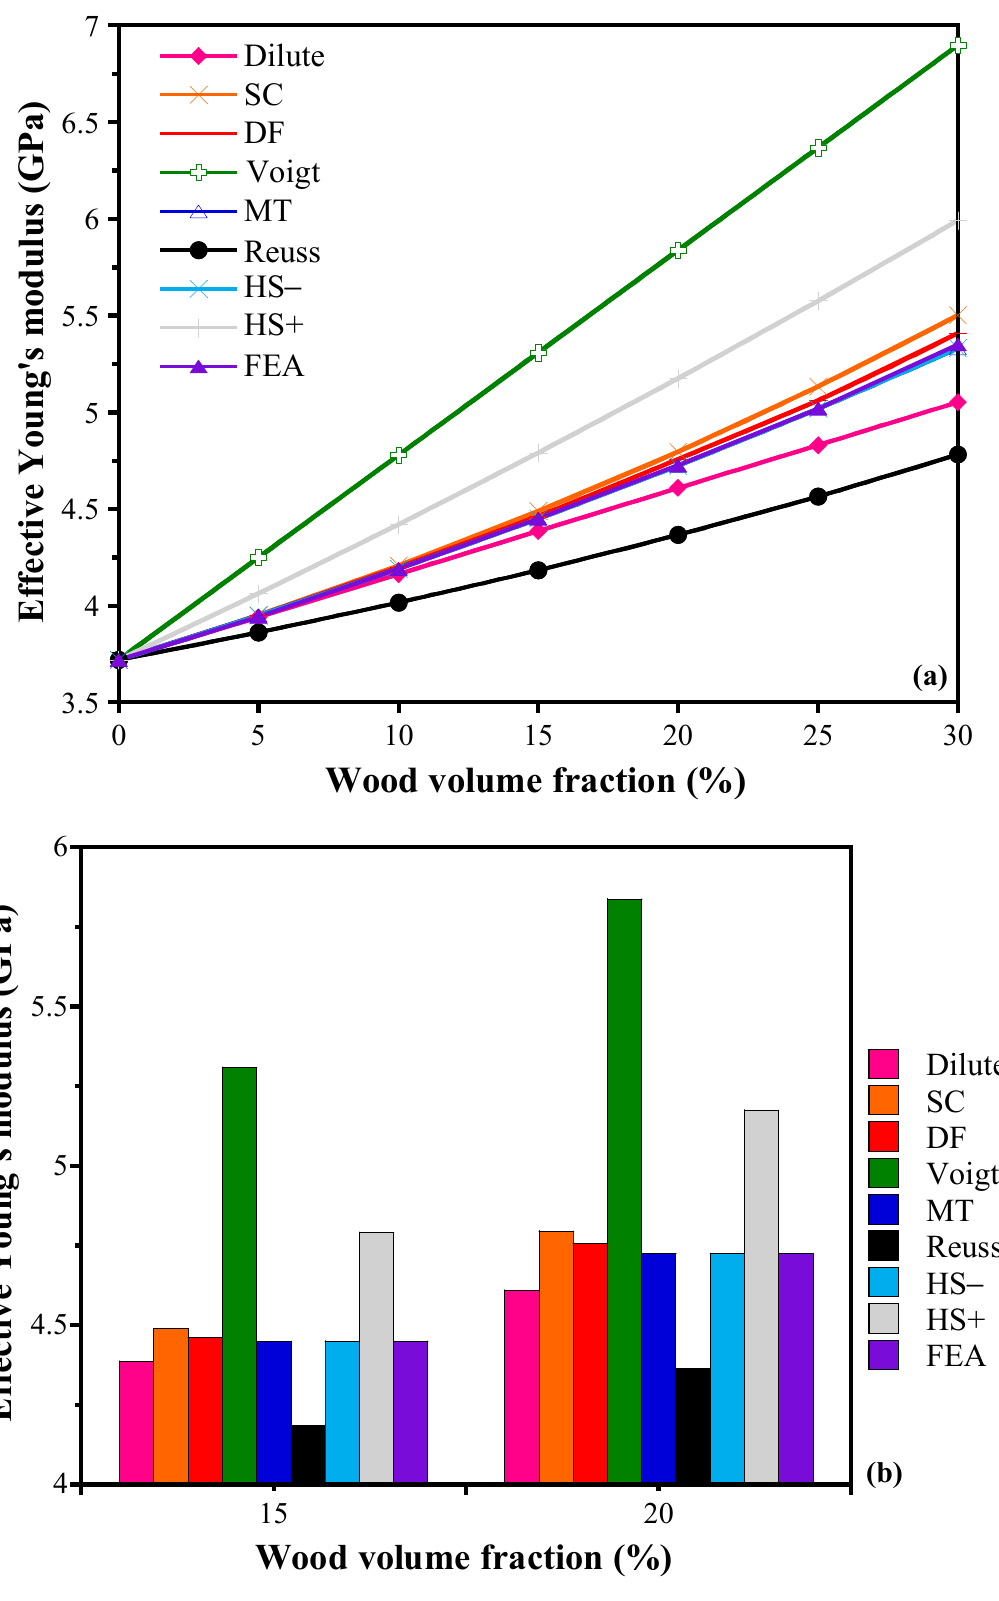
Figure 8. Comparison of analytic micromechanical models and FEA—( a ) effective Young’s modulus, ( b ) bar graph with effective Young’s modulus for 15% and 20% of wood volume fraction.